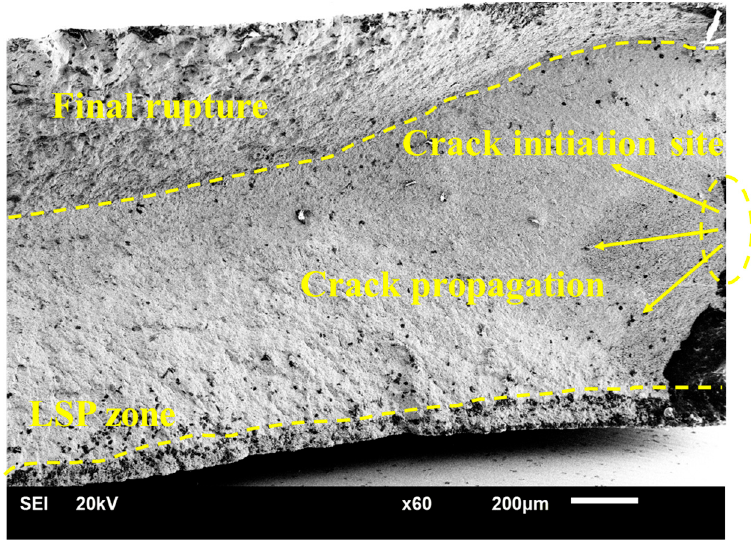
Figure 6. SEM diagram of fracture surface of the LSP-ed specimens.